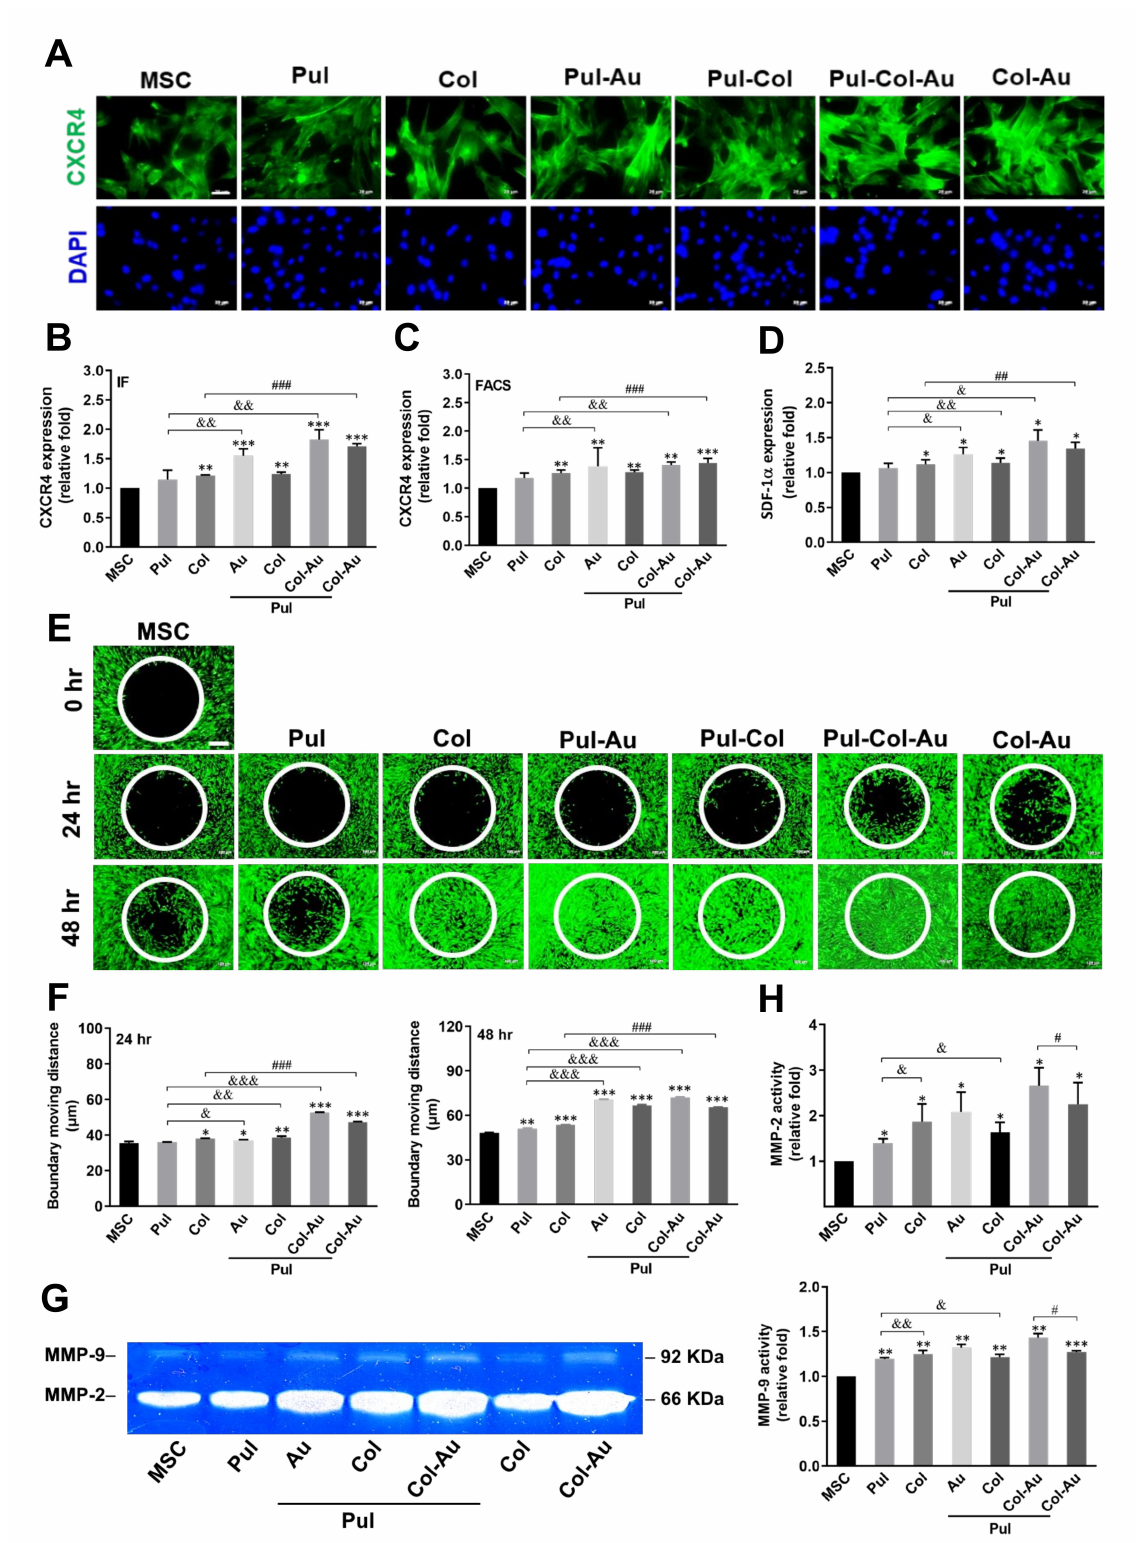
Figure 6. Assessment of biological function for MSCs culturing with various nanomaterials. ( A ) The immunofluorescence staining images of MSCs incubated with the anti-CXCR4 antibody (green color) and DAPI (blue color) at 48 h. Scale bar = 20 µ m. ( B ) The semi-quantification results of CXCR4 expression based on fluorescence intensity. ( C ) The CXCR4 positive cells were also detected and analyzed by the FACS method. ( D ) The expression of SDF-1 α protein was investigated and analyzed through ELISA assay at 48 h. ( E ) The real-time images of MSC migration influenced by different